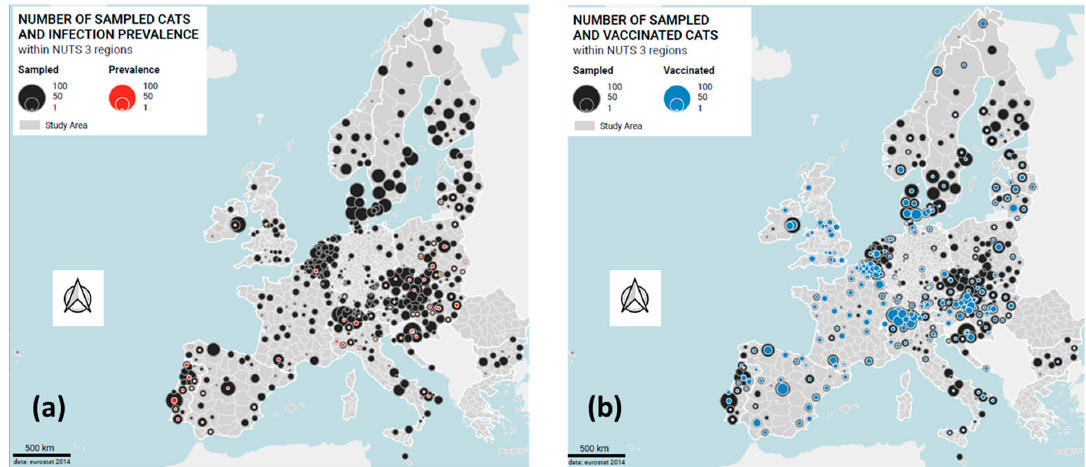
Figure 1. Origin and FeLV infection and vaccination status of the cats visiting veterinarians in the 30 European countries. ( a ) FeLV viraemia: black: all cats; red: FeLV-positive cats. ( b ) FeLV vaccination status: black: all cats; blue: FeLV vaccinated cats. The size of the circle represents the number of cats.